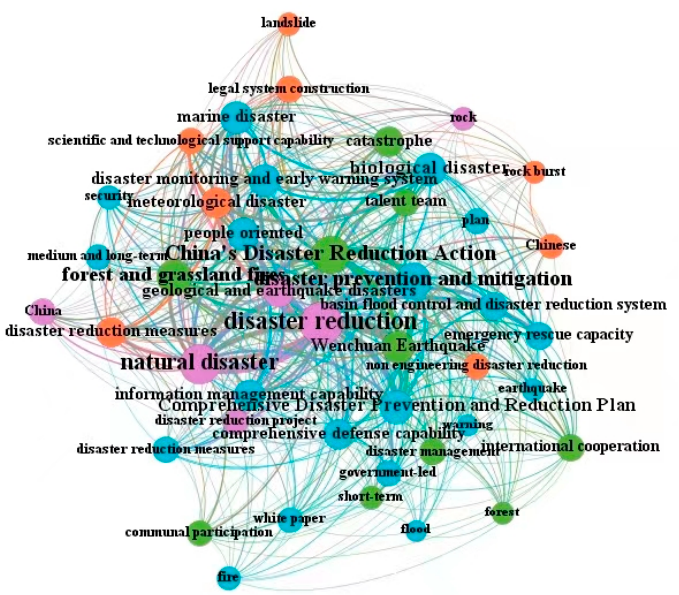
Figure 5. The keyword co-occurrence map of China’s dynamic disaster monitoring and early warning national policy in the initial development stage (2000–2007).